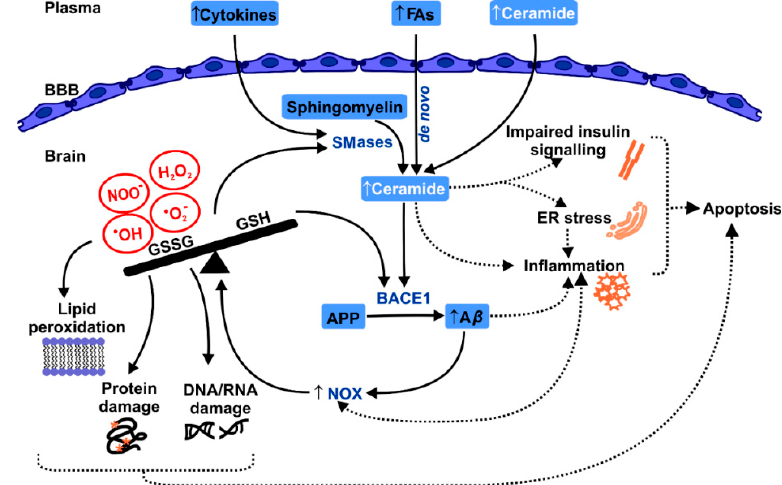
Figure 3. Crosstalk between ceramide, oxidative stress, and the brain insulin resistance. Ceramide plays a key role in the induction of brain IR. Peripheral IR is associated with an elevated ceramide generation. Ceramide like other neurotoxic lipids can pass through the blood-brain-barrier (BBB), contributing to the brain IR via liver-brain axis of neurodegeneration. In IR brain, ceramide can induce neuronal apoptosis and, similarly to Alzheimer’s disease, accumulation of amyloid β -peptides (A β ). However, a key mediator of A β -neurotoxic effects may not be the ceramide but rather oxidative stress. It has been demonstrated that A β induces activation of NADPH oxidase (NOX) associated with glutathione (GSH) depletion, lipid and protein oxidation, disturbances in glucose metabolism, as well as mitochondrial abnormalities. Abbreviations: A β , amyloid β -peptides; APP, A β precursor protein; BBB, blood-brain-barrier; BACE1, β -secretase; ER, endoplasmic reticulum; FAs, fatty acids; GSH, reduced glutathione; GSSG oxidised glutathione; NOX, NADPH oxidase; SMases, sphingomyelinases.